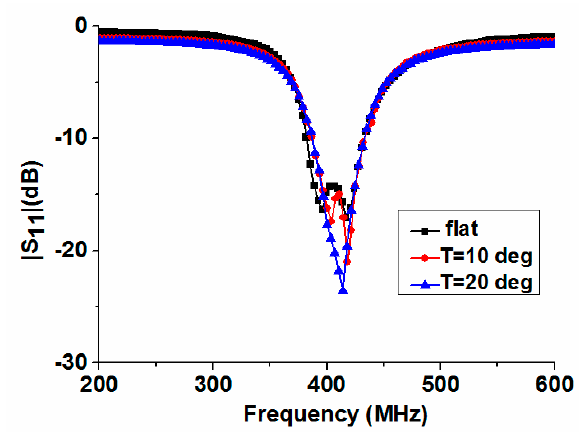
Figure 7. Measured | S 11 | of the flat and bent antenna with different angles.